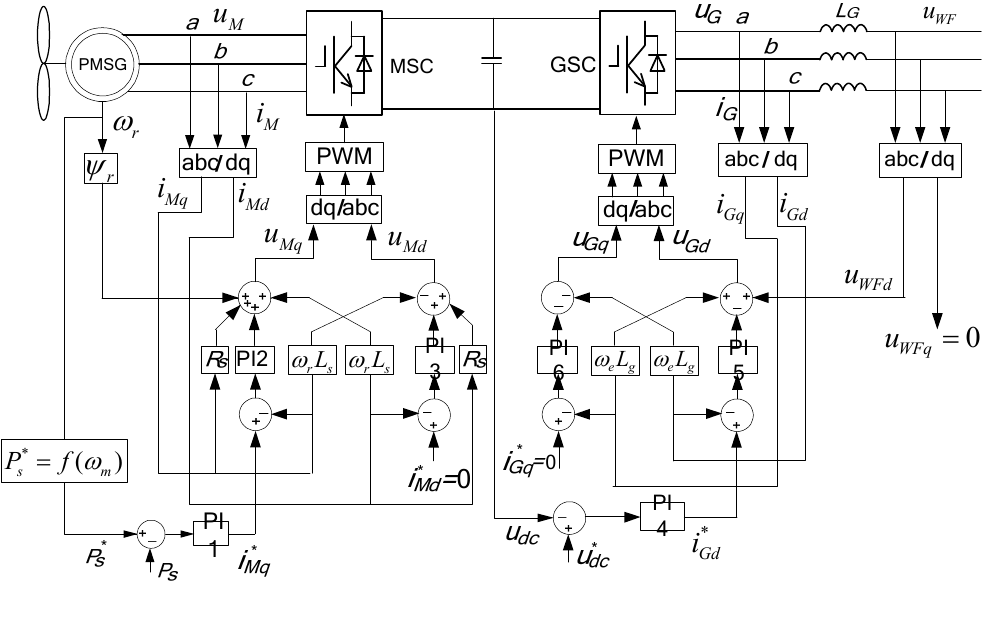
Figure 4. Control diagram of MSC and